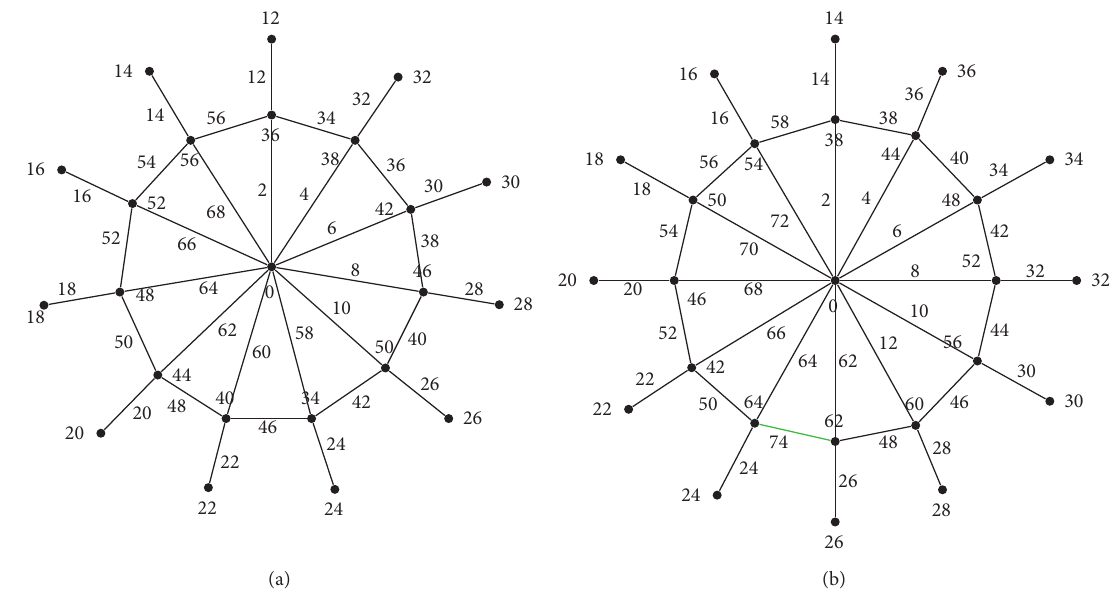
Figure 23: (a) 2-edge even graceful labeling of H